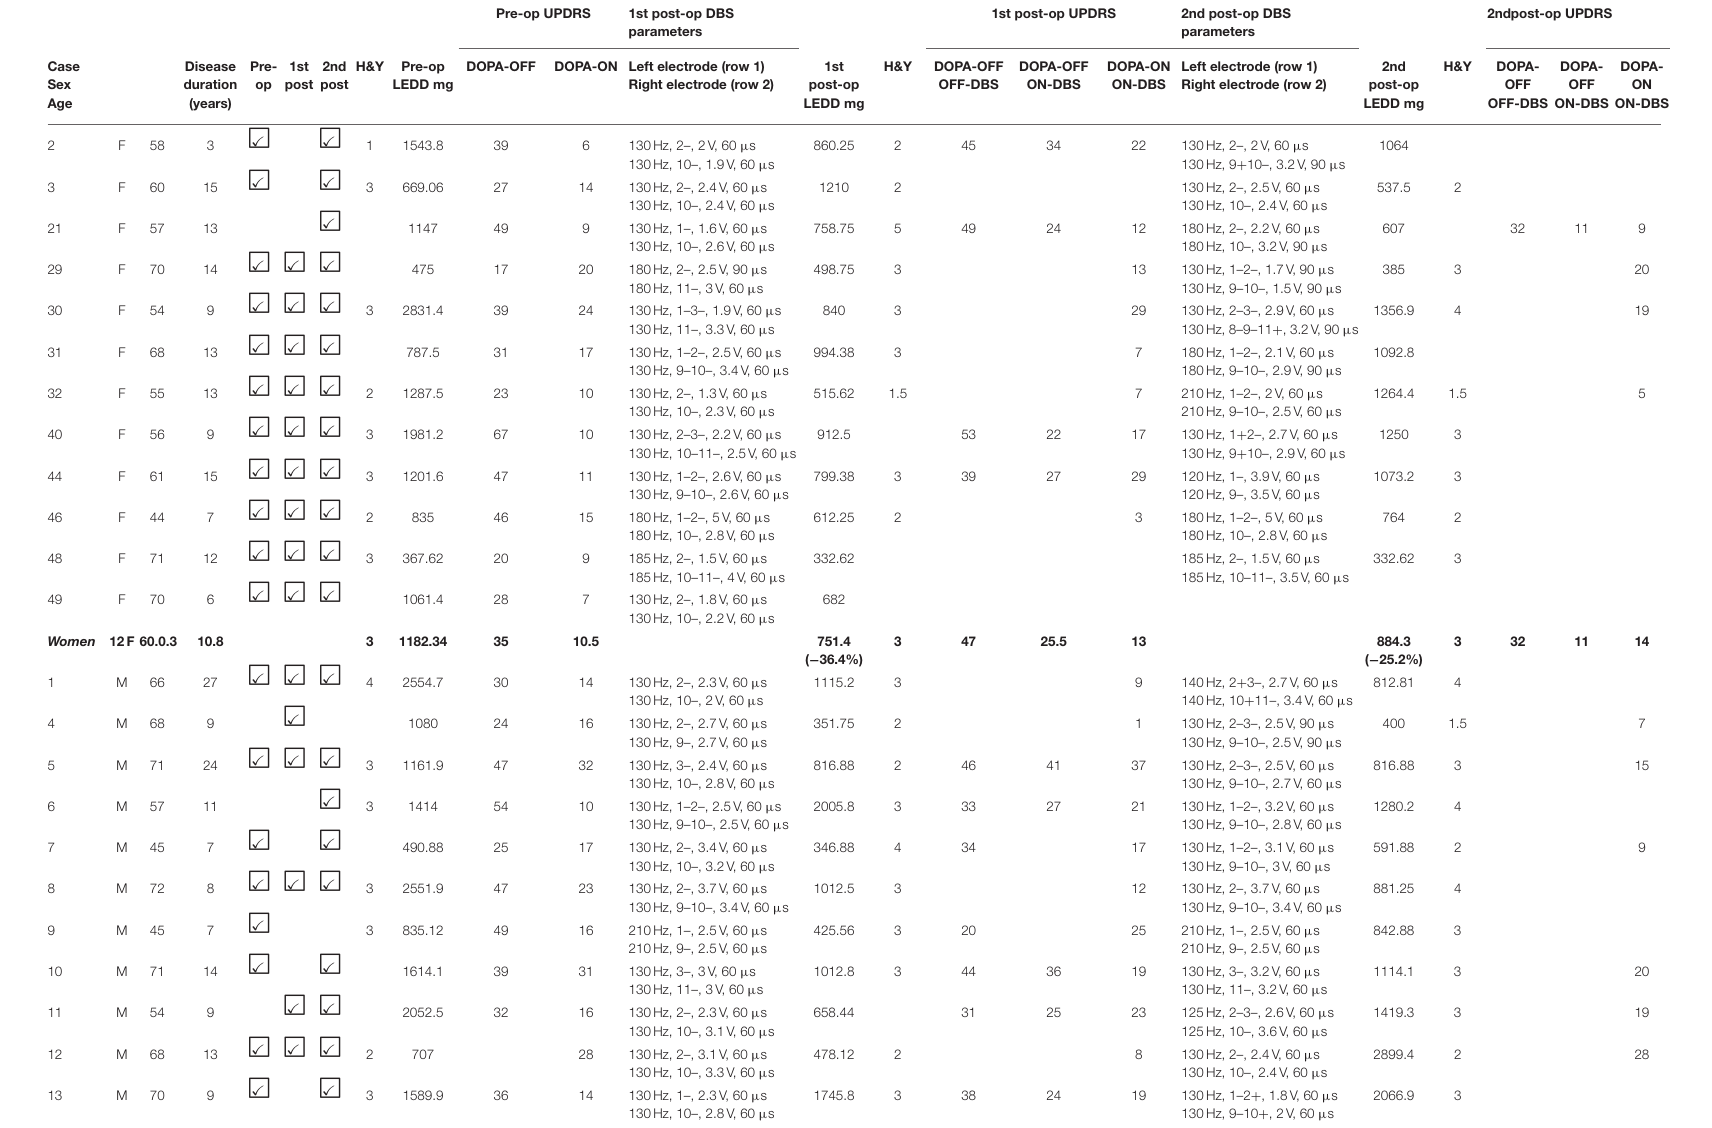
TABLE 1 | Clinical and demographic characteristics at the date of DBS neurosurgery, unless noted